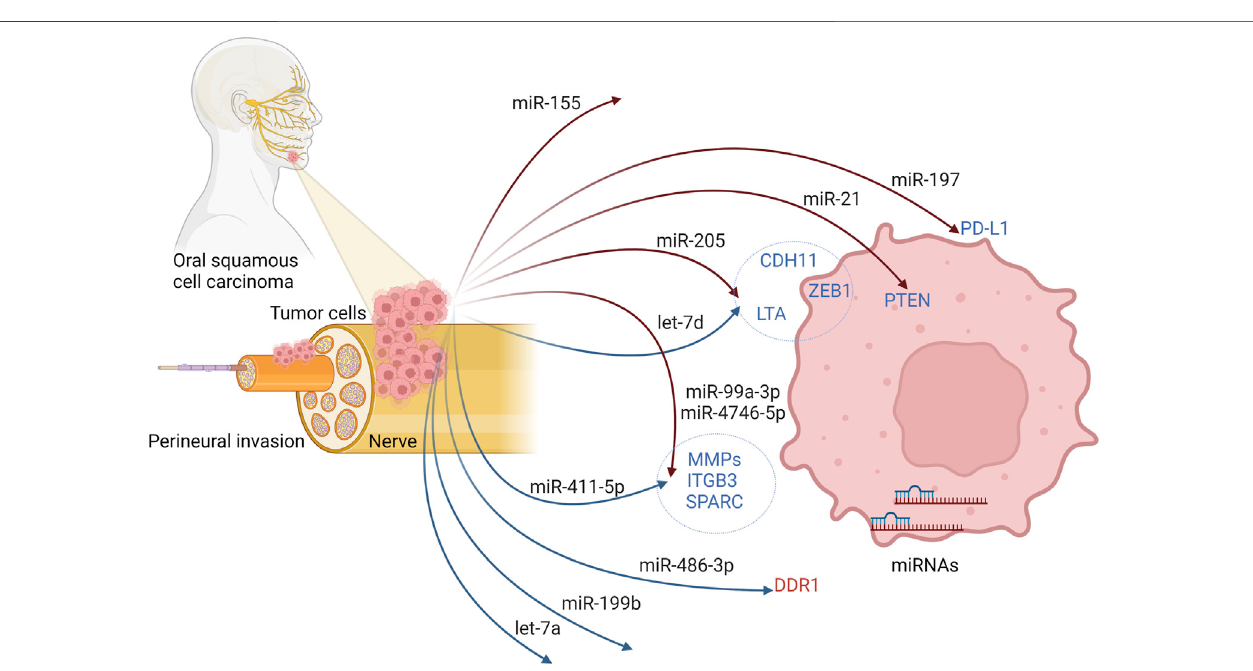
FIGURE 2 | Possible regulatory mechanism of miRNAs and their targeted genes to initiate PNI in oral squamous cell carcinoma. Created with BioRender.com.